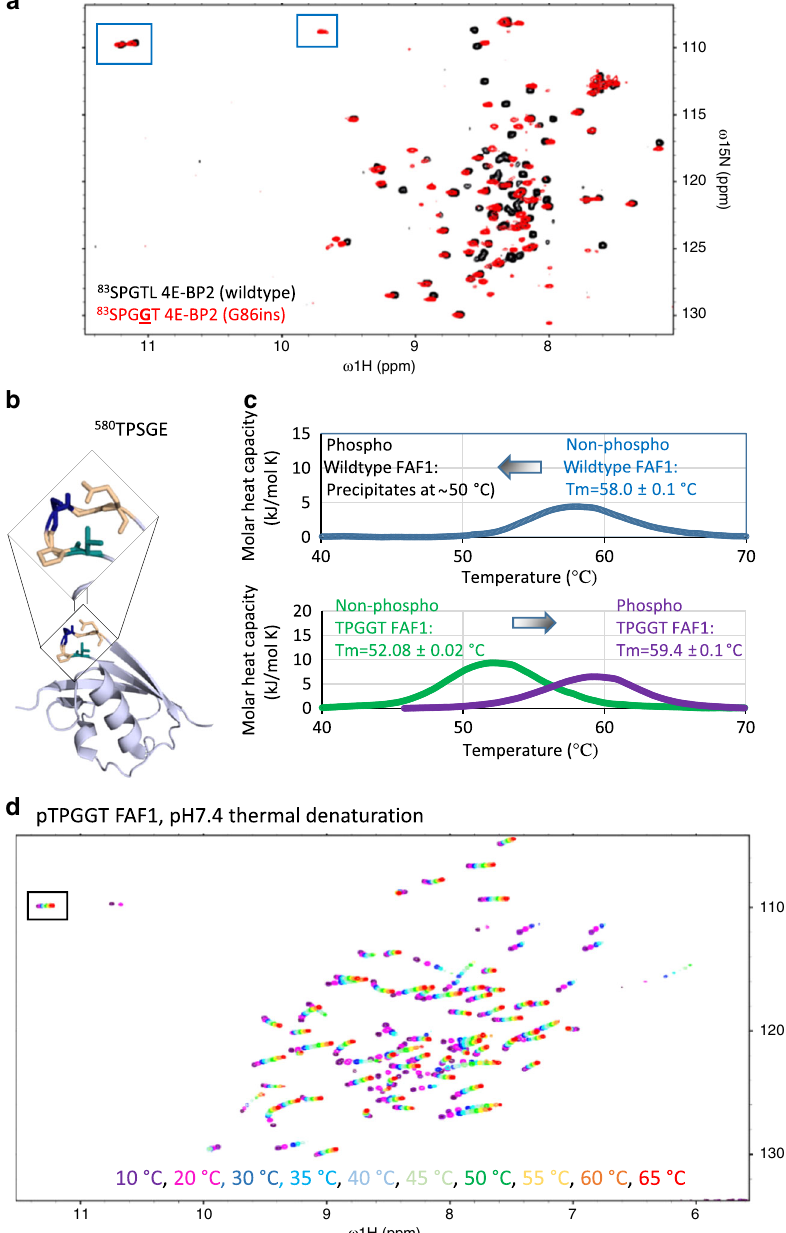
Fig. 7 Independent stability of the pTPGGT motif. a An extra hairpin can be added to the C-IDR of 5p-4E-BP2. 4E-BP2 has a pseudo-hairpin motif ( 83 SPGT) in the C-IDR, which does not form a hairpin normally. After inserting a Gly between G85 and T86, a hairpin structure is formed, demonstrating the hairpin ’ s independent stability. b Wildtype 580 TPSGE motif of the ubiquitin-like domain of FAF1 (residues 570 – 650, PDB ID 3QX1) forms a turn structure similar to the hairpin. c DSC data show that phospho-regulatory stability of pTPGGT can be transplanted into the FAF1 domain. d NMR thermal denaturation of pTPGGT FAF1 domain. The hairpin Gly is resistant to denaturation at pH 7.4 in a manner strikingly reminiscent to phospho 4E-BP2 (see Fig.